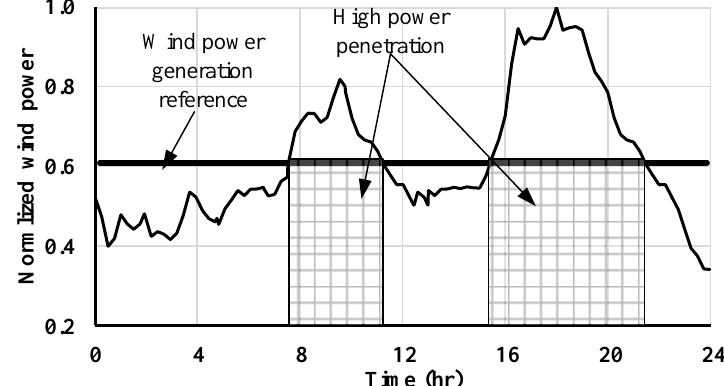
Figure 13. Wind power generation.